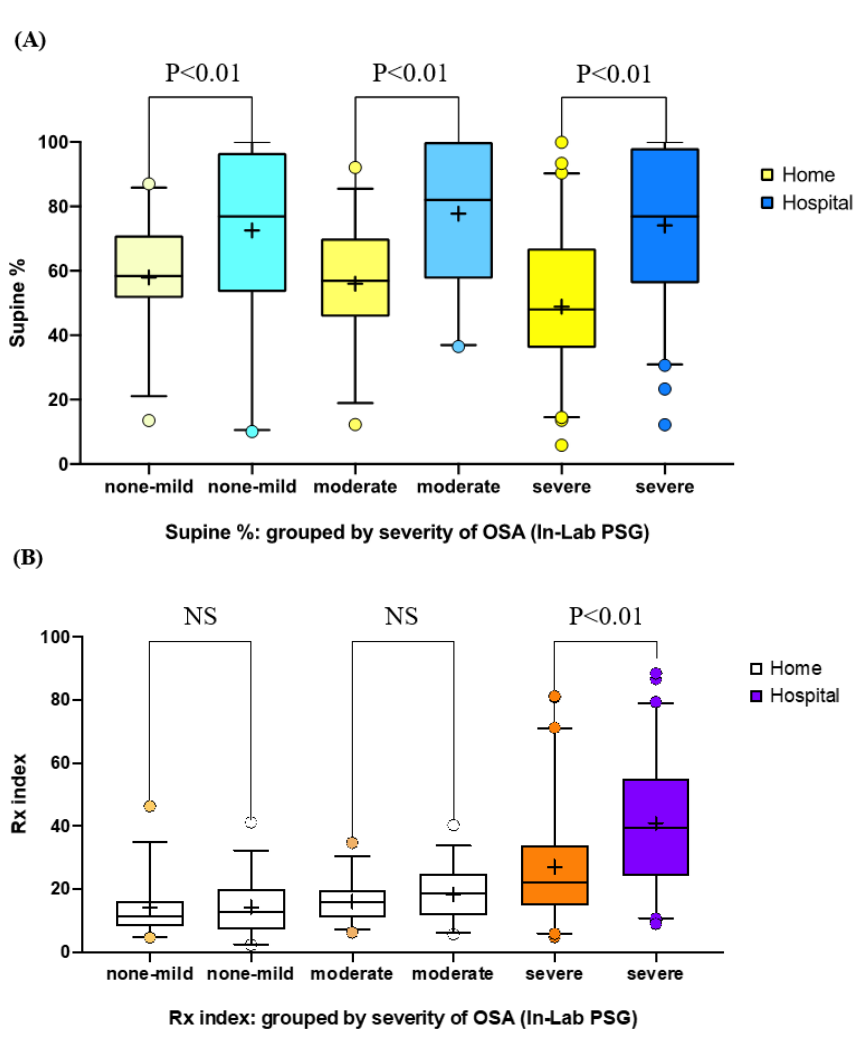
Figure 2. Comparison of the variation in the percentage of supine sleep time and Rx index values ob-